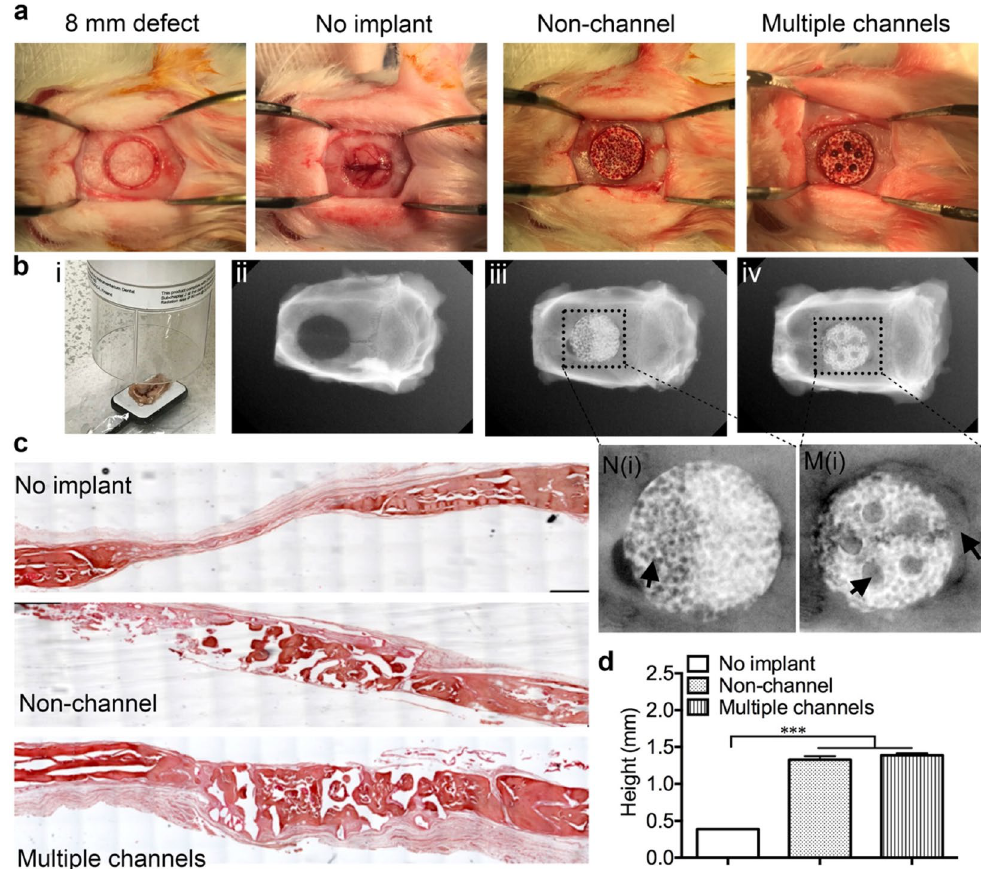
Figure 6. In vivo implantation and characterization: bone defects with 8 mm diameter and around 1.5 mm depth were created in the calvarial bone of rats ( a ), and scaffolds were implanted into the defects. X-ray microCT was scanning the explants ( b , i) and X-ray photographical pictures on bone in the groups: (ii) no implant; (iii) non-channel; (iv) multiple channels. ( c ) H&E staining on the tissue sections of the three groups. ( d ) The height of the new formed tissue in the defect zone after 12 weeks. (n = 3, *** p <